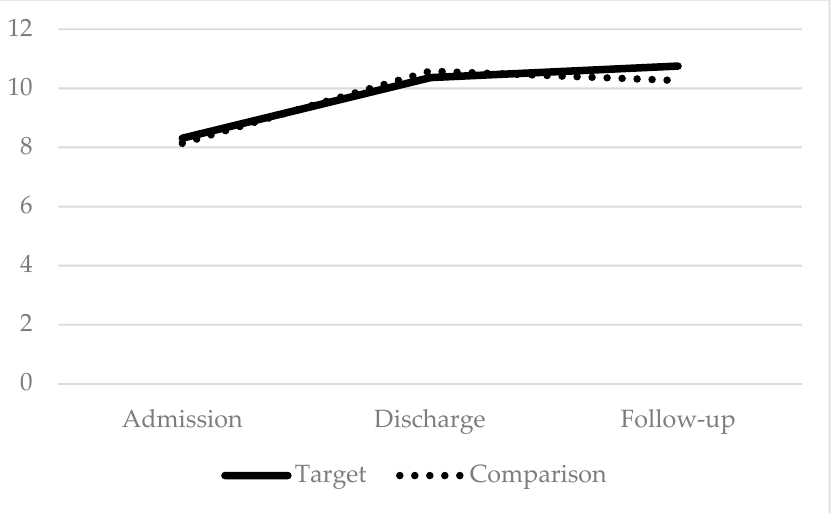
Figure 2. Coping: higher scores indicate improvement.